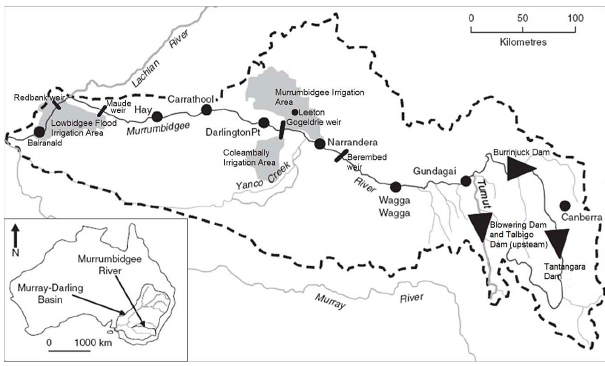
Figure 1. Location of the Murrumbidgee basin within the Murray– Darling river basin (Kandasamy et al.,